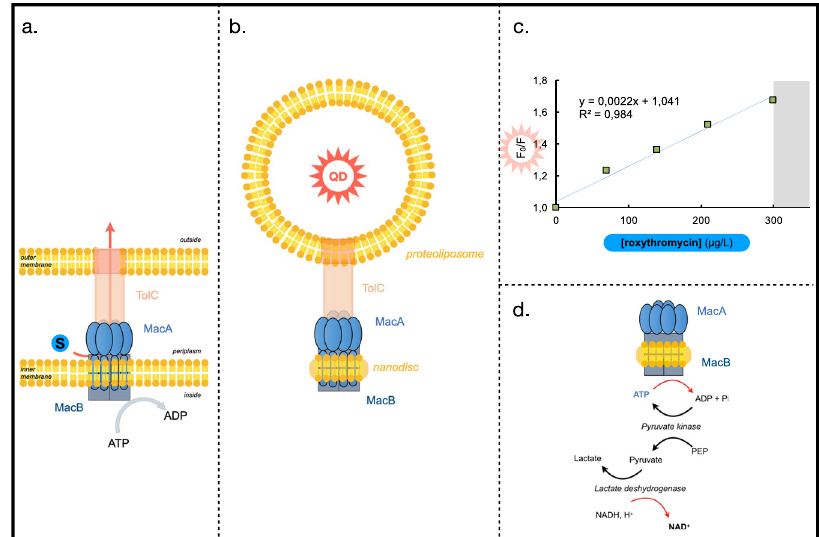
Fig. 1 Rationale of the assay. a Schematic representation of the ef fl ux pump assembly in E. coli membranes. The MacAB-TolC pump encompasses the two-membrane barrier the Gram negative bacterium. A trimer of TolC, embedded in the outer membrane, protrudes into the periplasm and docks onto a hexamer of MacA that mediates the interaction with the periplasmic domain of MacB, which is a dimer. b Schematic representation of the in vitro assay. MacA and MacB, in lipid nanodiscs and TolC in proteoliposomes form the tripartite complex upon mixing and incubation. Transport through the whole ef fl ux pump is studied by monitoring ATP hydrolysis and antibiotic transport from the solution, representing the periplasmic space to the interior of the liposome representing the exterior of the bacteria. c Stern – Volmer plot. Quenching of the quantum dots fl uorescence in the presence of increasing concentrations of roxithromycin. Results are best described by the Stern – Volmer type equation: F 0 /F = 1 + K SV [S], where F and F 0 are the fl uorescent intensities of the QDs at a given roxithromycin concentration and in a roxithromycin-free solution, respectively. d NADH-coupled ATPase assay. Hydrolysis of ATP is coupled to the oxidation of NADH as a consequence of two consecutive enzymatic reactions. First, ADP generated upon ATP hydrolysis is regenerated to ATP by pyruvate kinase (PK) that catalyzes the transition of phosphoenolpyruvate (PEP) to pyruvate. Pyruvate is then reduced to lactate by lactate dehydrogenase (LDH), which concomitantly catalyzes the oxidation of NADH. Hence, decrease in ATP concentration is directly and stoichiometrically correlated to the decrease in NADH